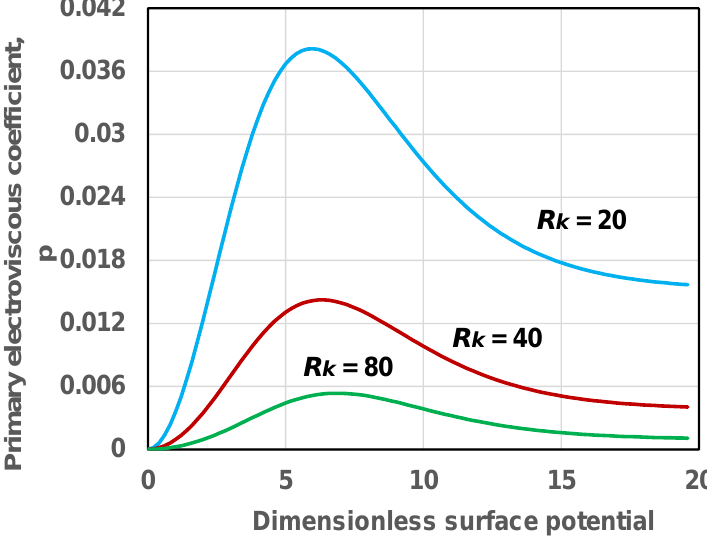
Figure 3. Variation of primary electroviscous coefficient p with dimensionless surface potential (cid:101) ψ 0 for different values of R κ